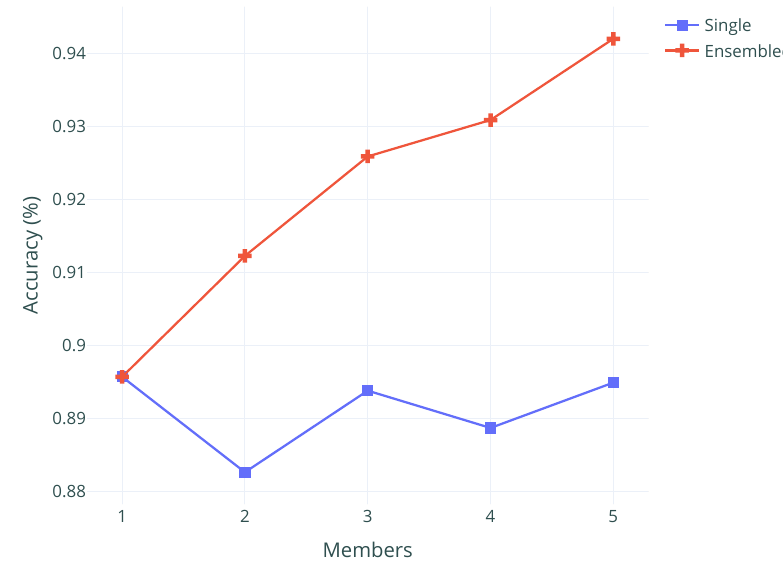
Figure 4. Comparison of Bayesian and ensemble